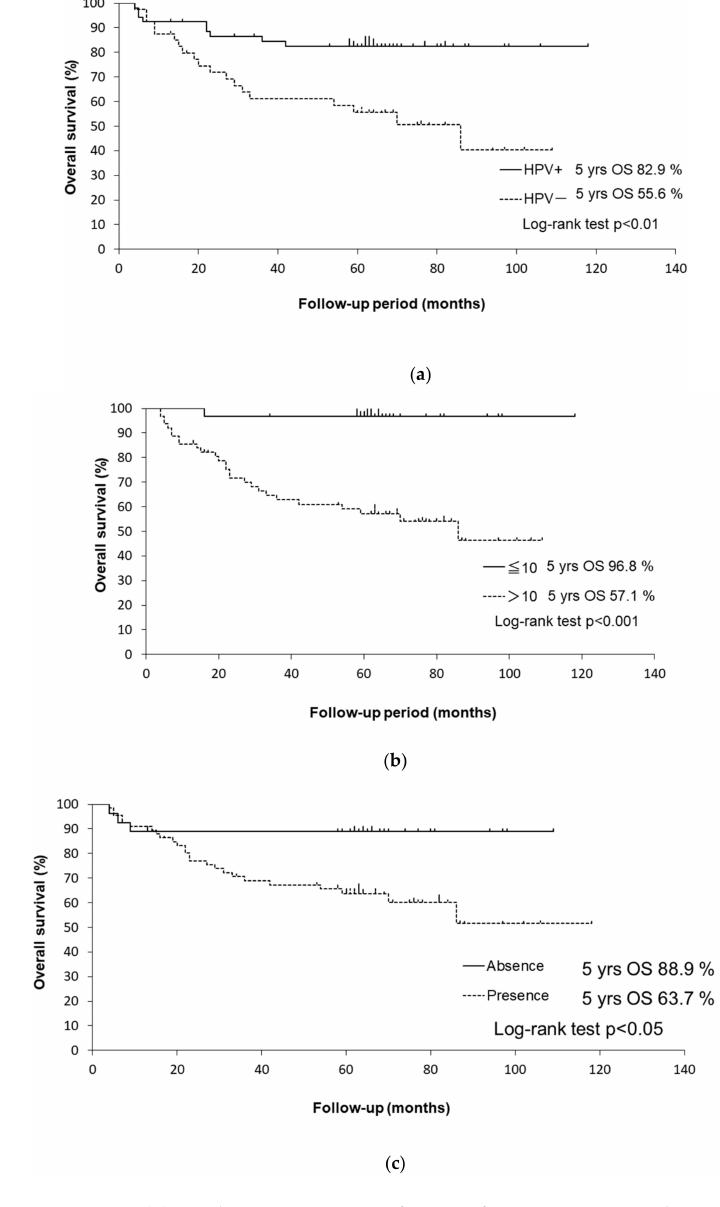
Figure 2. ( a ) Kaplan–Meier curves for OS of HPV-positive and HPV-negative patients. ( b ) Kaplan– Meier curves for OS of patients with a ≤ 10 and with a > 10 pack-years smoking history. ( c ) Kaplan–Meier curves for OS of patients with/without alcohol